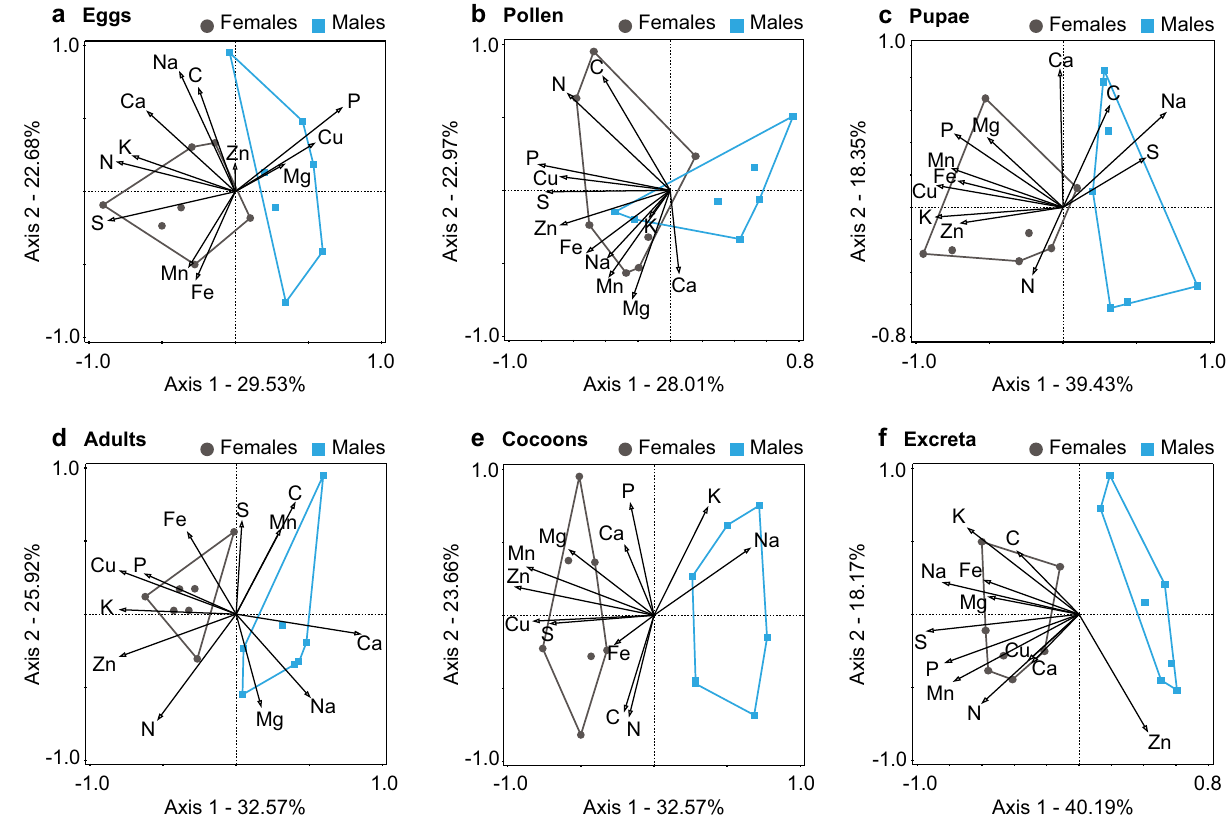
Figure 3. The sexes differ in the stoichiometry of every component of their elemental budget. PCA plots— multivariate analysis of the stoichiometric relations of the O. bicornis elemental budget; calculated according to the concentrations of elements. The first two axes are presented. The percentage of variation explained is given for both axes. The patterns shown in the graphical representation of PCAs were confirmed by t-tests computed independently for the 1st- and 2nd-axis scores (p < 0.05). Detailed results are shown in the